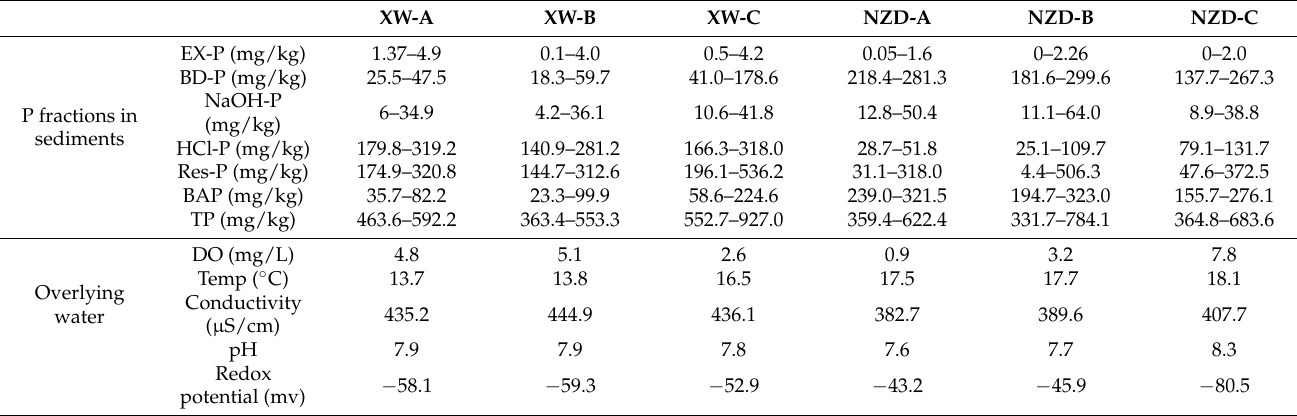
Table 2. Contents of the different fractions of P in the sediments and the environmental characteristics of the overlying water.